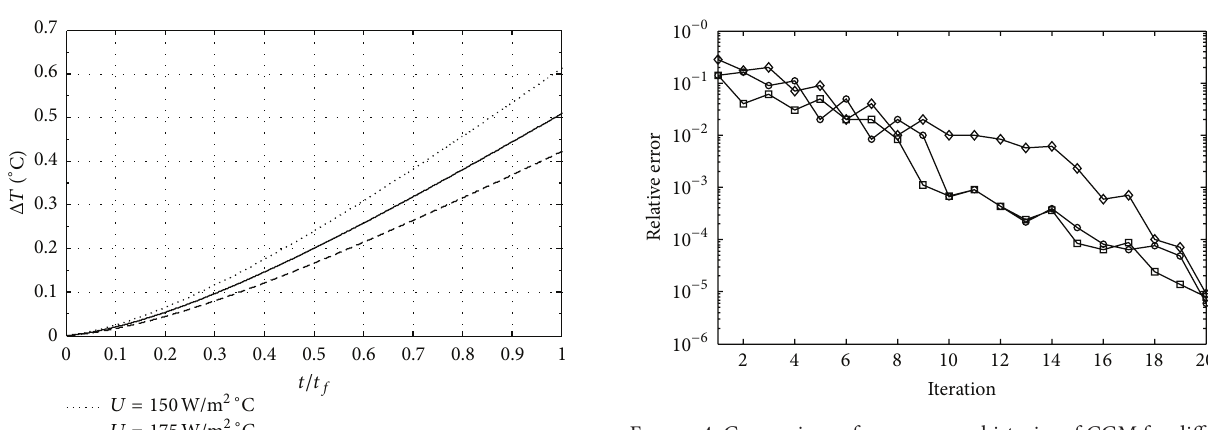
Figure 4: Comparison of convergence histories of CGM for differ-